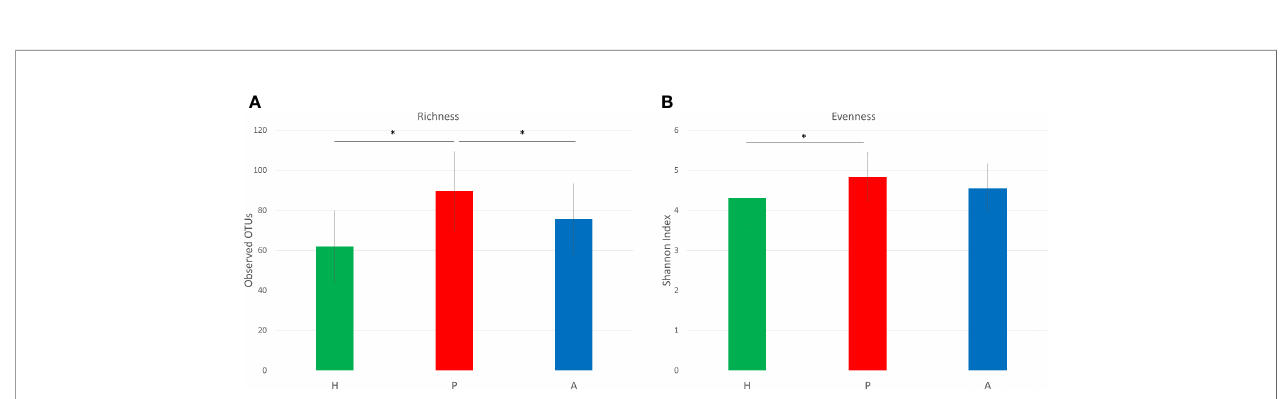
FIGURE 2 | Alpha diversity of the subgingival microbiome. (A) Richness of the subgingival microbiome. Richness is represented by the number of operational taxonomic units (OTUs). (B) Evenness of the subgingival microbiome. Evenness is represented by Shannon index. (*p < 0.05; H (green): healthy; P (red): periodontitis before non-surgical therapy; A (blue): periodontitis after non-surgical